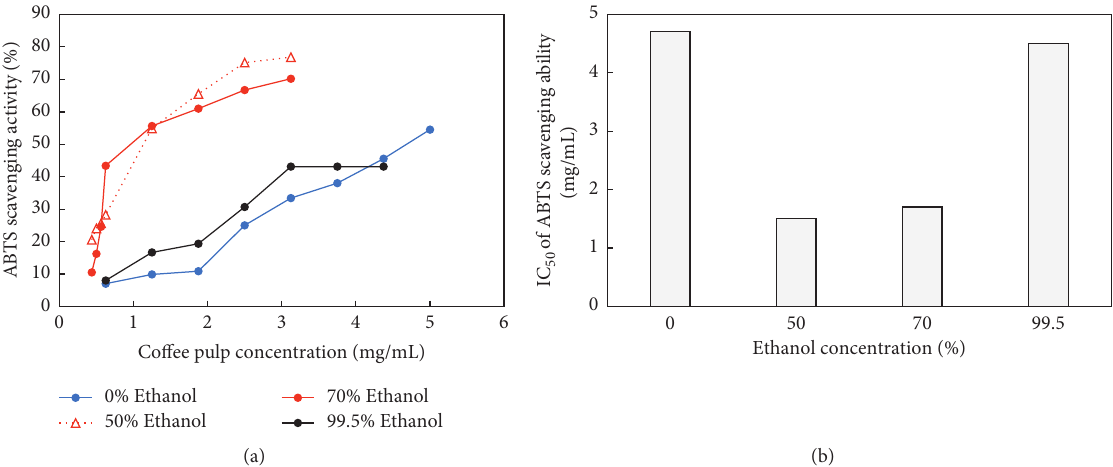
Figure 5: ABTS-free radical scavenging capacity of the coffee pulp extracts obtained using different ethanol concentrations. (a) ABTS-free radical scavenging activity; (b) IC 50 of ABTS-free radical scavenging activity.